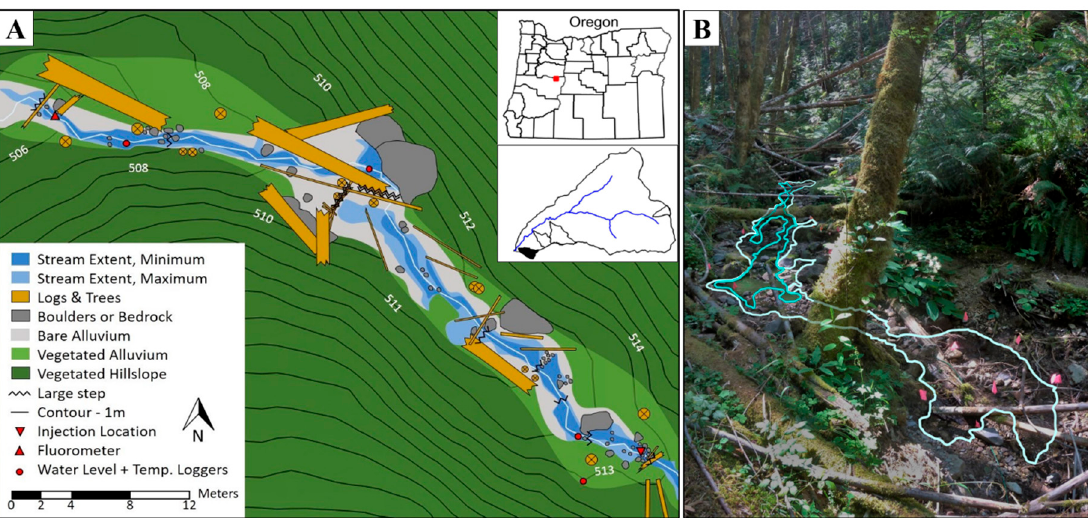
Figure 1. ( A ) Plan-view map of the study reach, including surface water extent at the diurnal minimum and maximum, channel morphology, reach topography, and logger locations. ( B ) Image looking upstream at the large step in the middle of the reach. Annotation added to show the wetted perimeter at the diurnal maximum (light blue) and minimum (darker blue) extent.